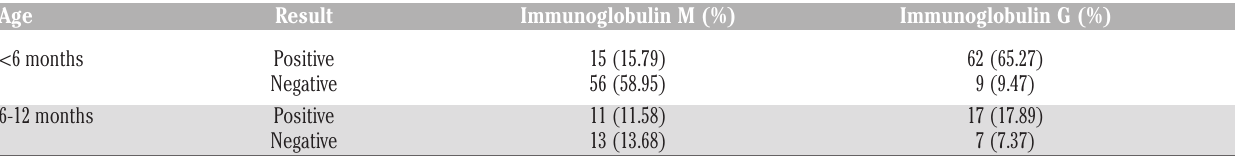
Table 4. Anti-rubella immunoglobulin test